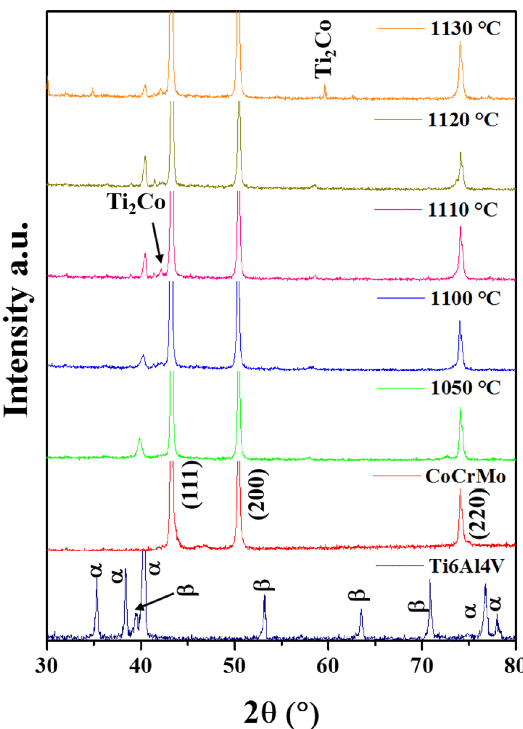
Figure 7. XRD patterns of samples sintered at different temperatures.